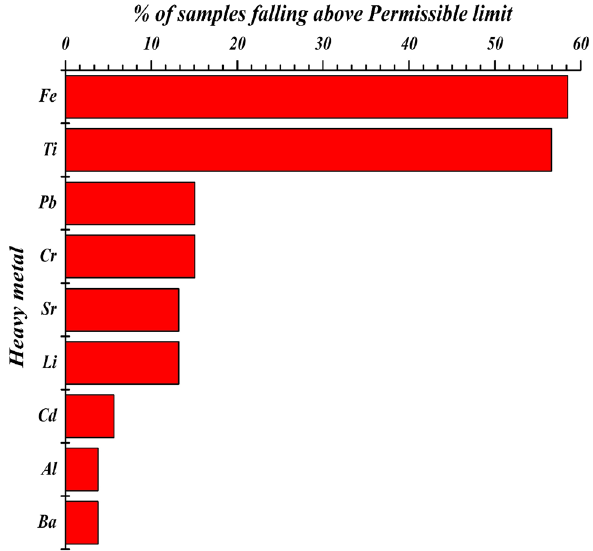
Fig. 2 Percentage of samples falling above the permissible limit of the drinking water